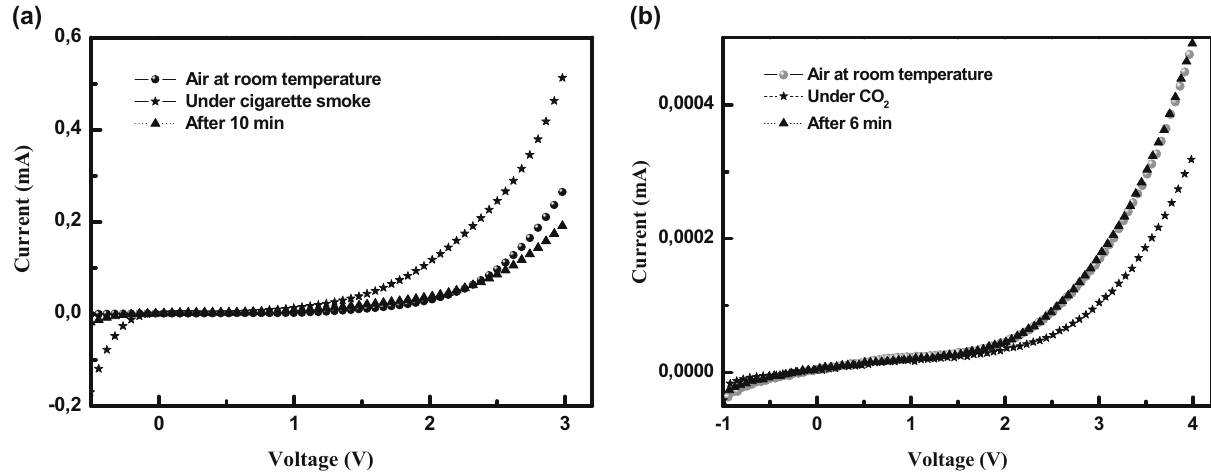
Figure 6: I – V characteristics of PTh/oxide PSi structure with 6 VCs: ( a ) under cigarette smoke and ( b ) under CO 2